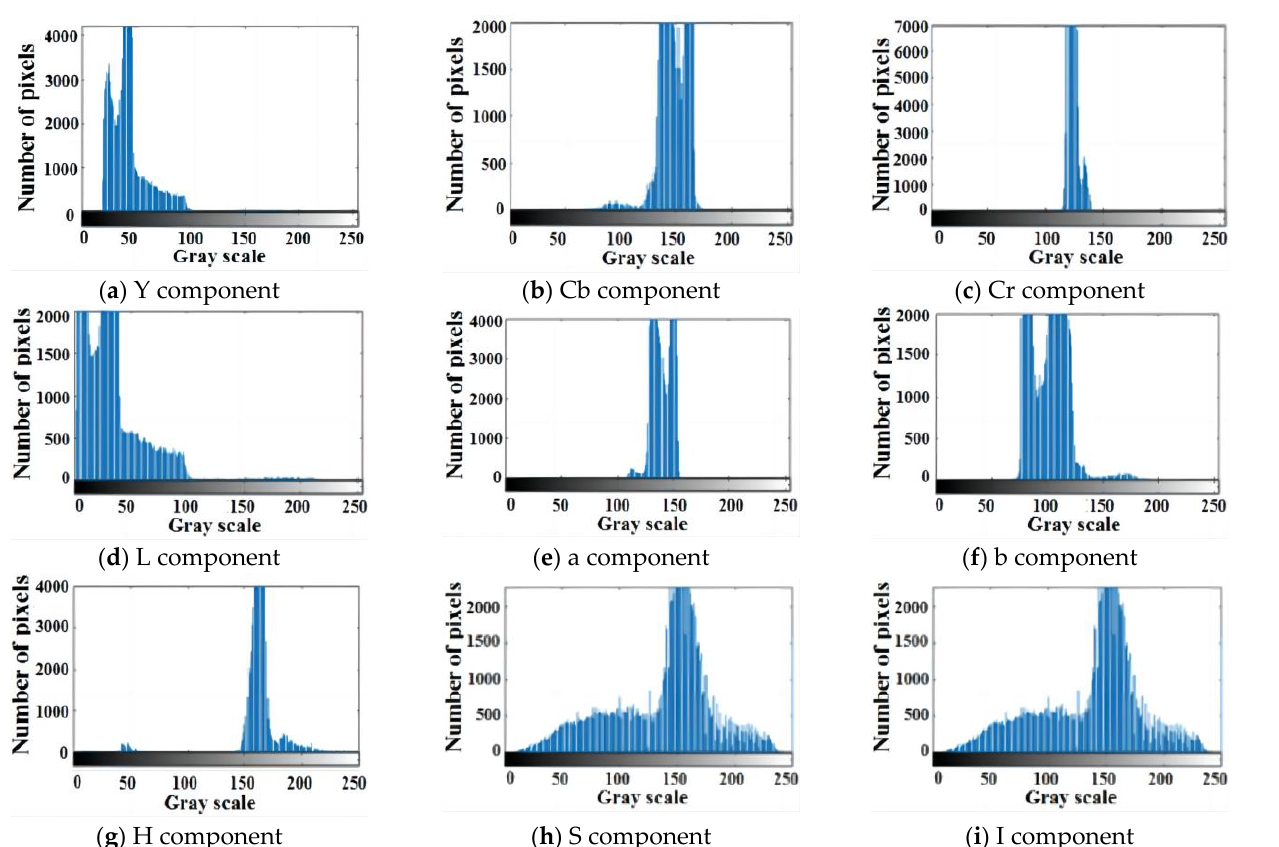
Figure 6. Color space histogram of citrus UV image. Through the analysis of the YCbCr, Lab, and HSI color model components, the Cb component, the defective part, and the non-defective part hardly overlapped, but the